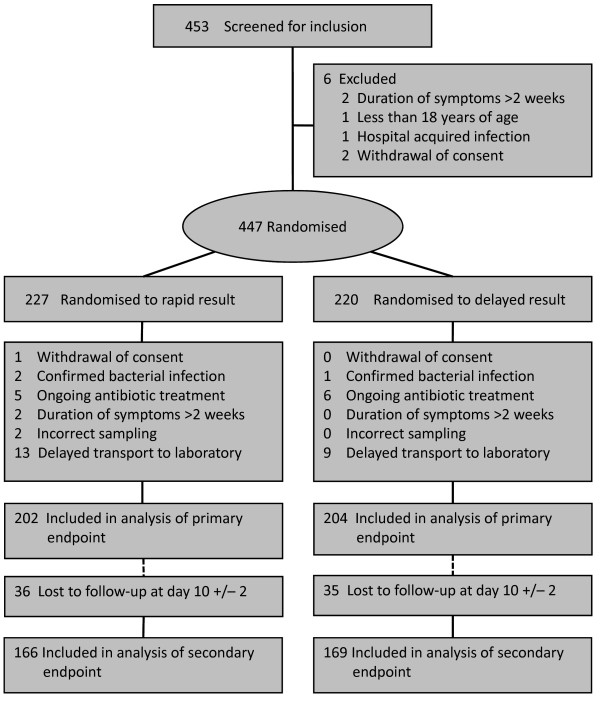
Flowchart of patients.